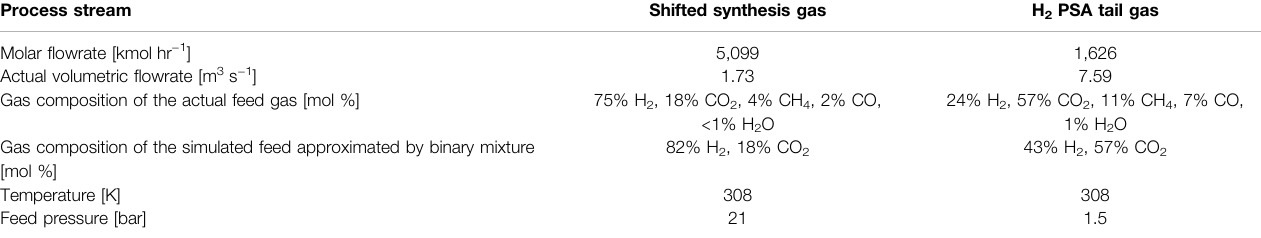
TABLE 1 | Stream conditions of two VPSA feed gases in the SMR hydrogen plant at the production capacity of 6.8 ton H 2 /hr. Process stream